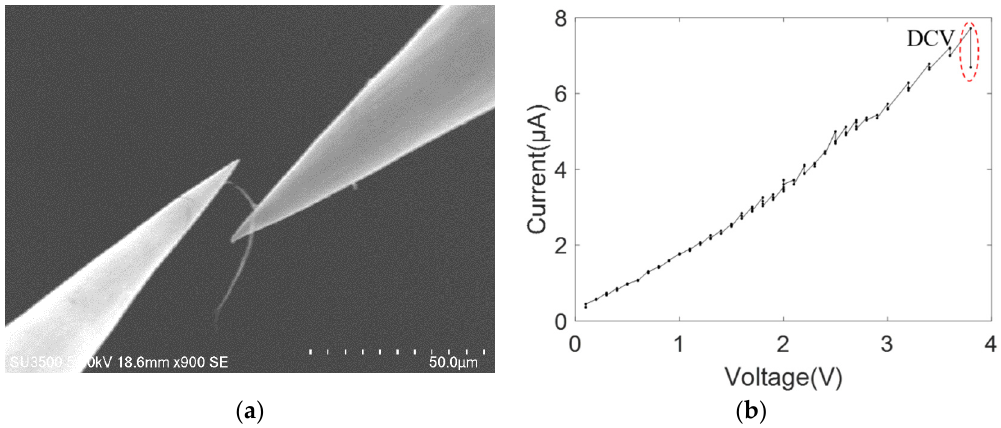
Figure 8. MWCNT bundle contacting with two tungsten probes ( a ) SEM image; ( b ) current–voltage curve.